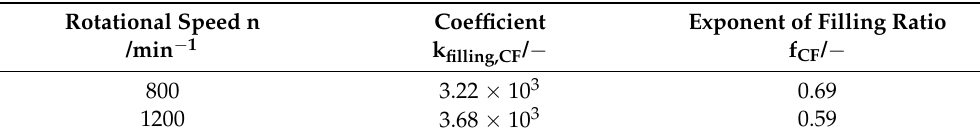
Table 12. Variables for model equation (Equation (19)) to describe specific collision frequency based on media filling ratio ϕ media ( − ) for d media = 10